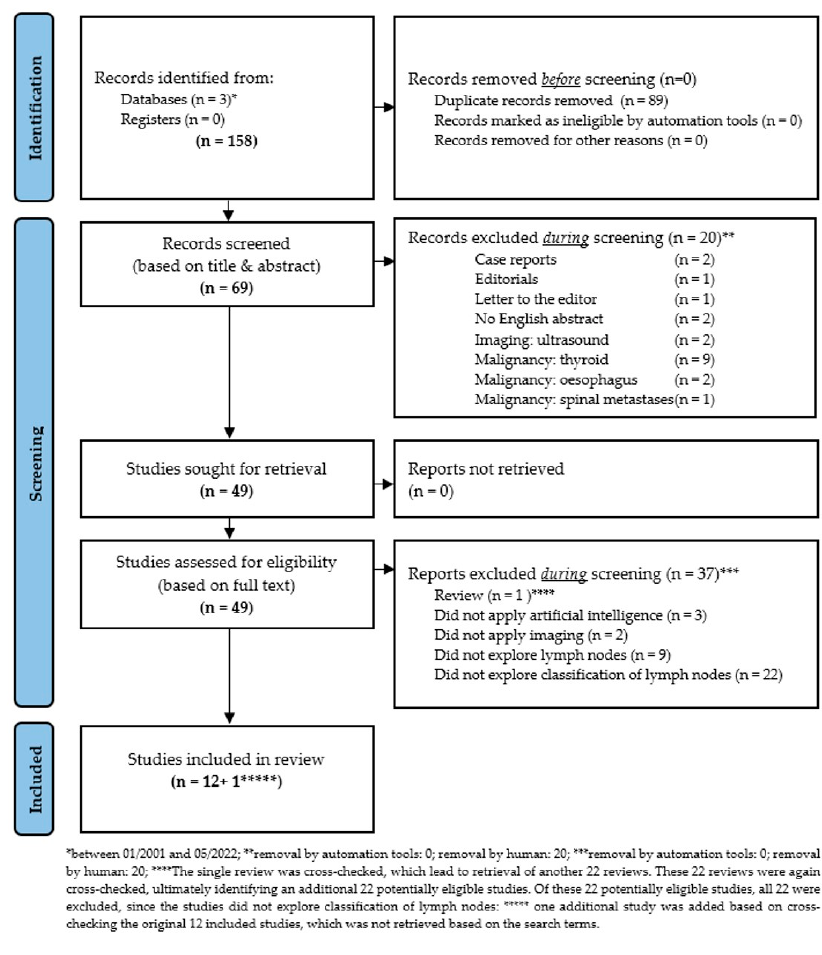
Figure 1. Modified PRISMA 2020 flow diagram for new systematic reviews, which includes searches of databases and registers only, as proposed by Page MJ and co-authors [29].